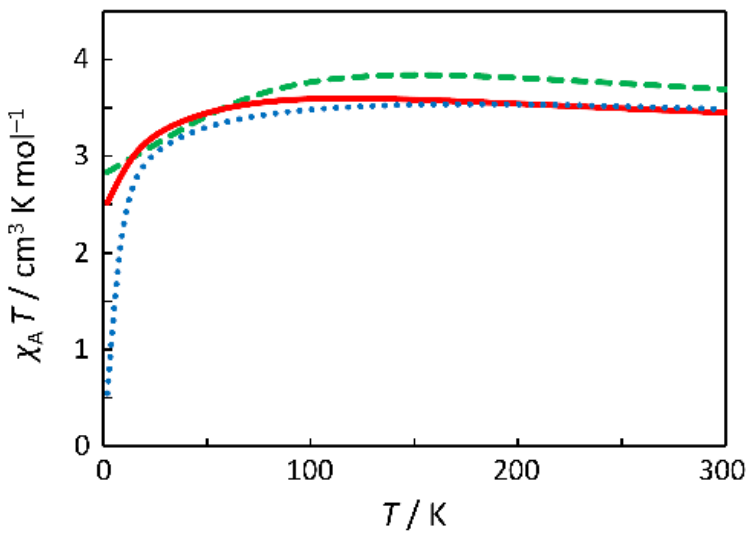
Figure 3. Theoretical χT versus T curves with Δ = −350 cm −1 ( v = 5) (―), Δ = 0 cm −1 ( v = 0) (‒ ‒ ‒), and Δ = +350 cm −1 ( v = −5) (·····) and with fixed parameters ( λ , κ ) = (−100 cm −1 , 0.70).